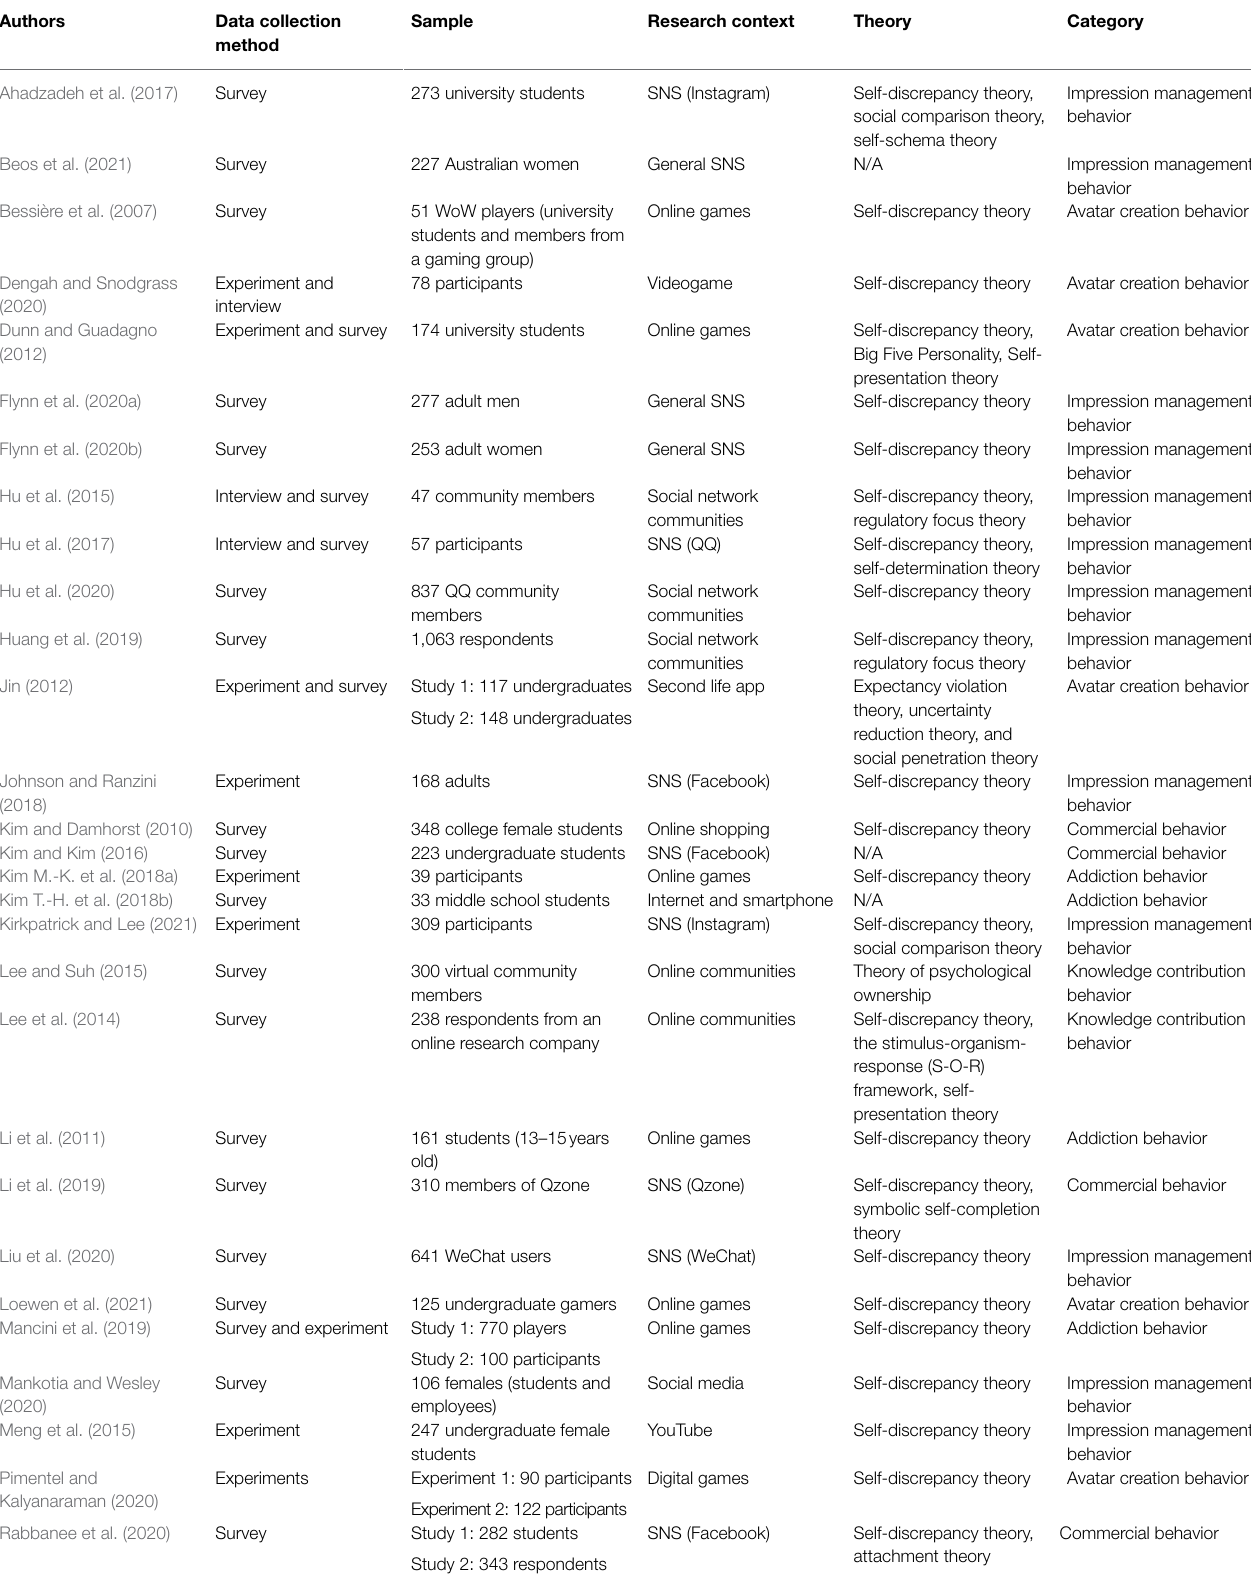
TABLE 1 | Basic characteristic of reviewed